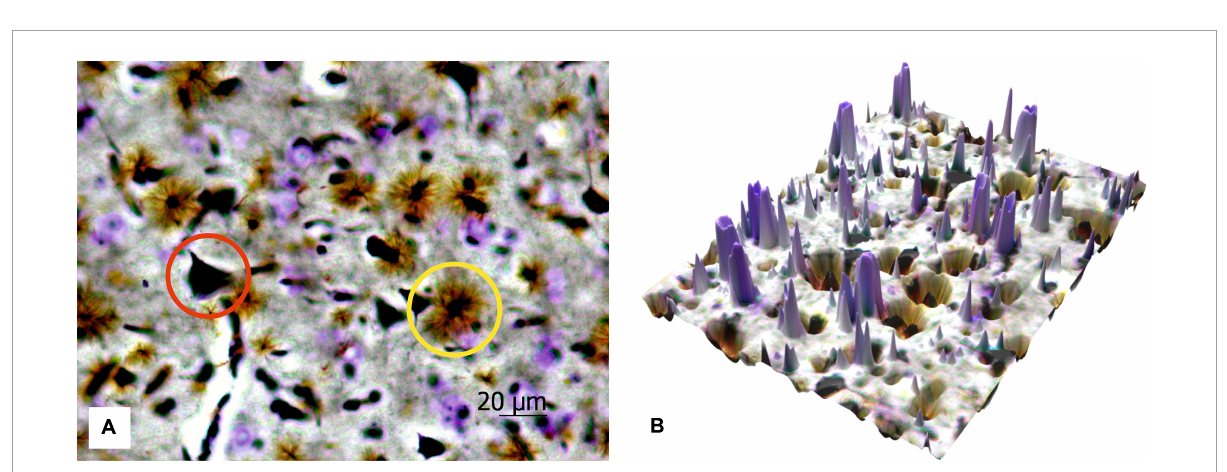
FIGURE6 The 2D image of rat motor cortex (A). The protoplasmic astrocytes (yellow circle) and impregnated neurons (red circle) are in focus, and the neurons stained with cresyl violet are sharp. Ob. 40x, oc. 20x; (B) corresponding 3D surface for the 2D histological image of the same histological